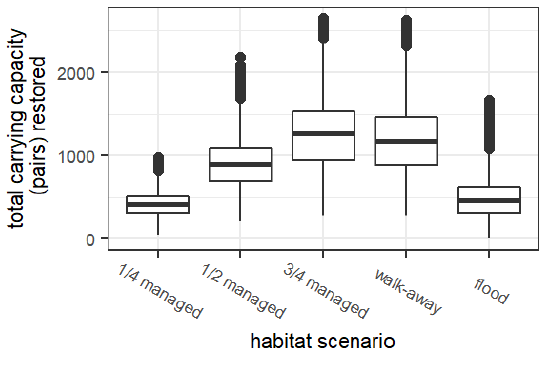
Fig. 6 . Cumulative habitat added to the carrying capacity (measured in number of pairs) over the duration of model simulations under the different habitat management